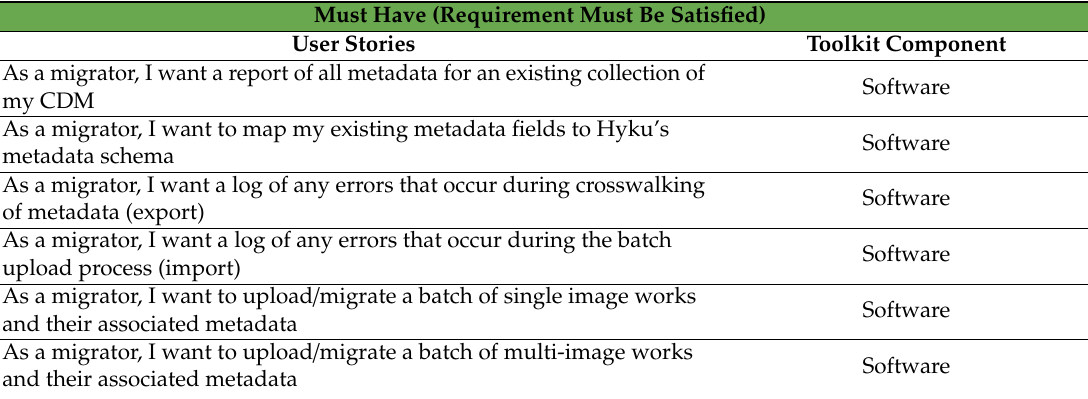
Table A1. Prioritized user